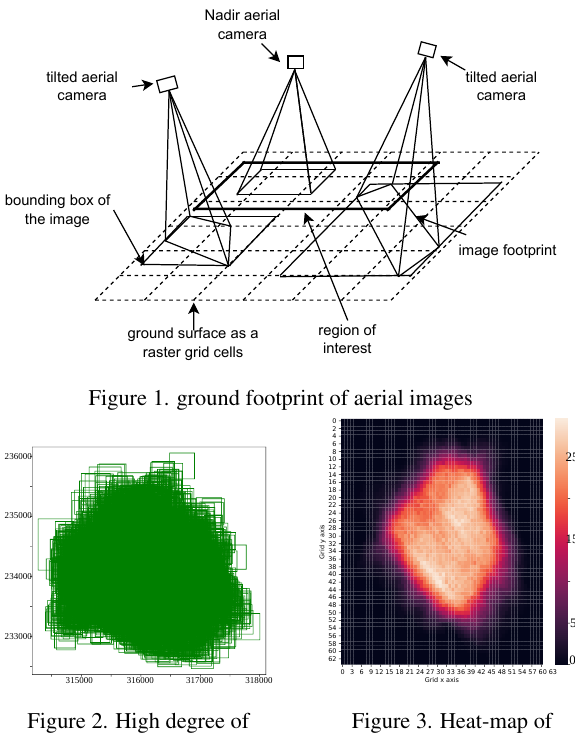
Figure 3. Heat-map of image